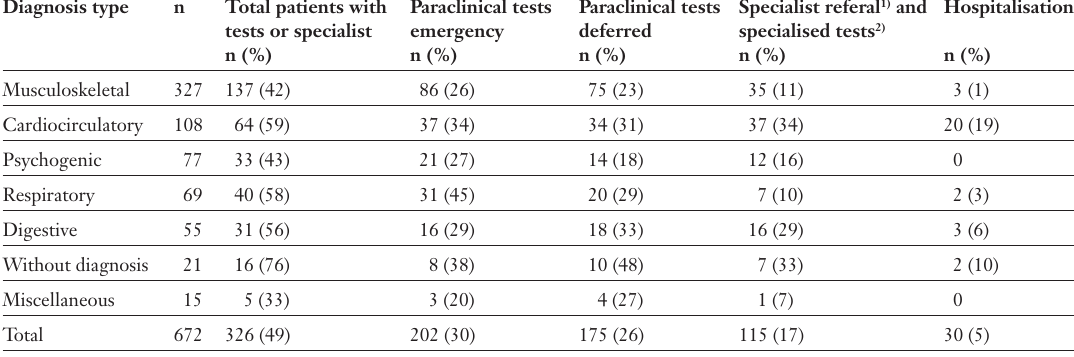
Paraclinic tests, referral to specialists and hospitalisation up to three months of